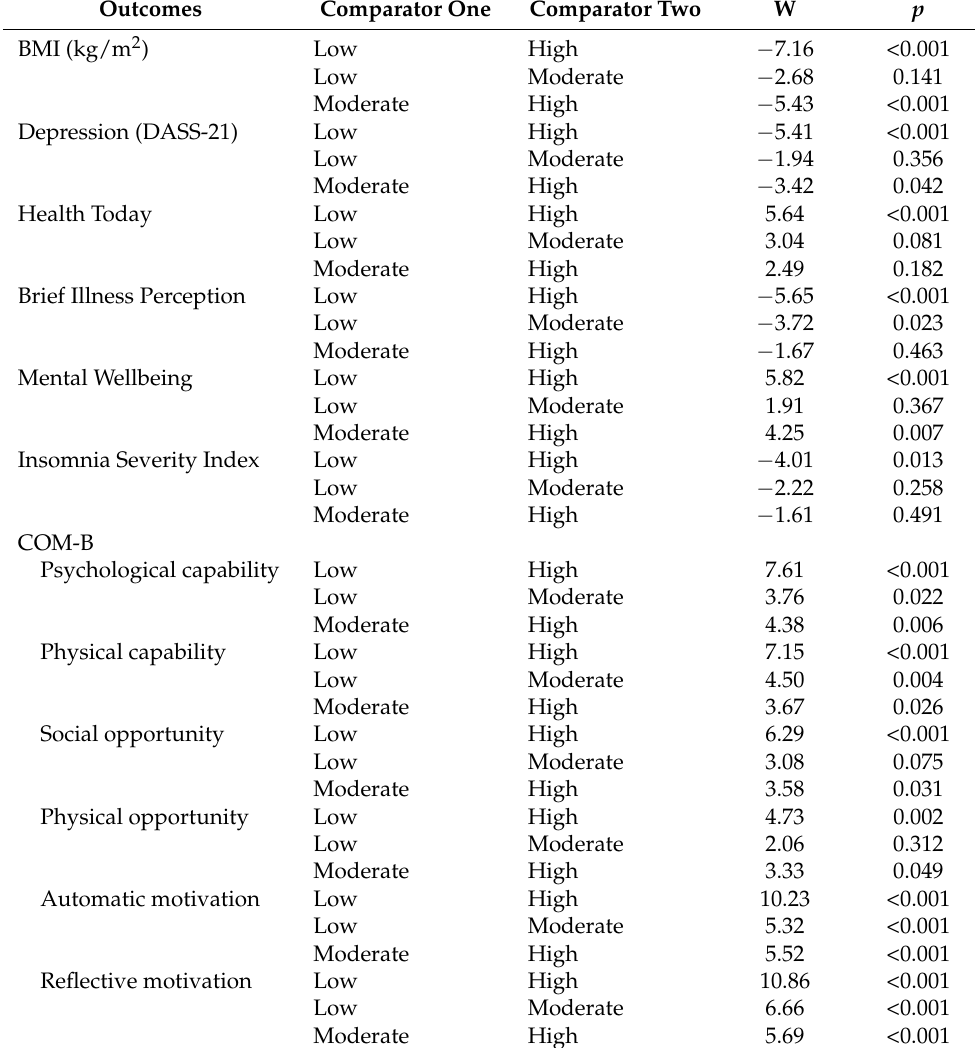
Table 3. Dwass–Steel–Critchlow–Fligner (DSCF) pairwise comparisons for variables where statistical significance was found in the Kruskal–Wallis analyses (Table 1). Comparator groups represent categorical group membership based upon physical activity classification (low; moderate; high) according to the International Physical Activity Questionnaire